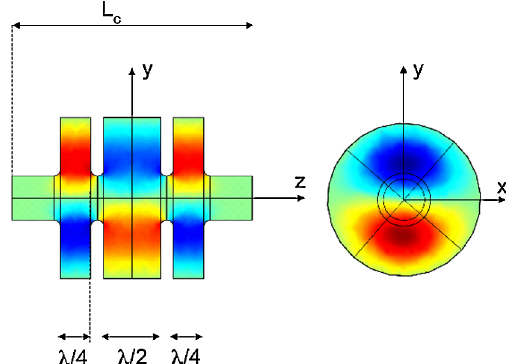
FIG. 16. Geometry of the TM used for the simulation presented in this paper. The superim- posed false-color pattern represents the value of the E blue and red colors, respectively, correspond to the maximum and minimum values of the